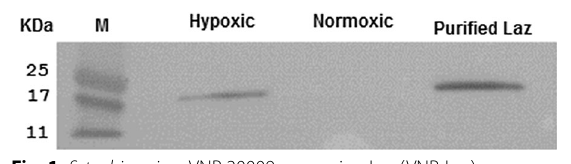
Fig. 1 S. typhimurium VNP 20009 expressing Laz (VNP‑Laz) was cultured under normoxic or hypoxic conditions for 24 h, the media were then collected concentrated and probed onto an immunoblot with anti‑Lip/H.8 mAb 2C3